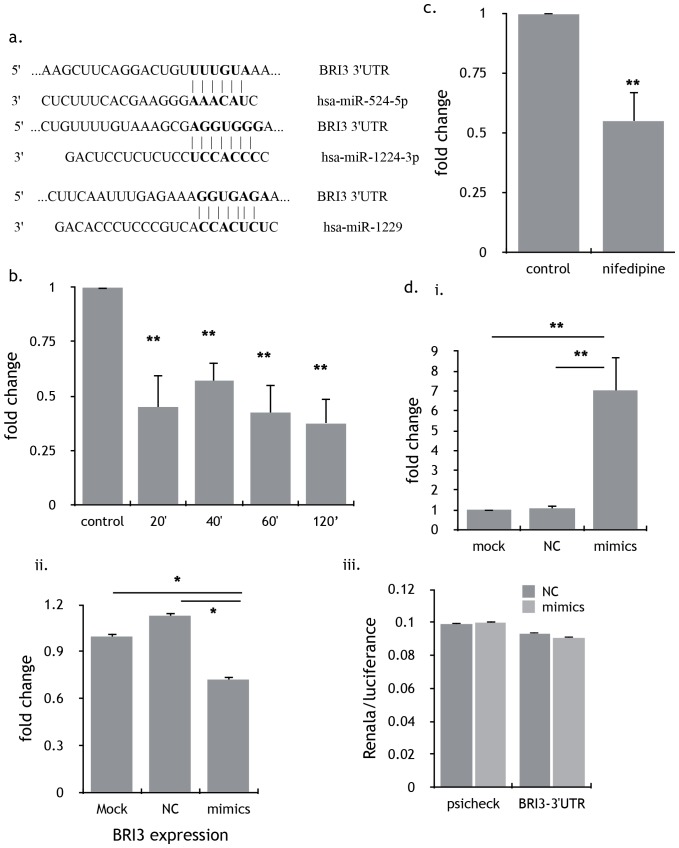
miRNA-524-5p was target of nifedipine and regulated the expression of BRI3.a) Predicted duplex formation between human BRI3 3′-UTR (top) and three miRNA (bottom) including has-miRNA-524-5p, hsa-miR-1224-3p, hsa-miR-1229 by using TargetScan software. b) The expression of miRNA-524-5p decreased in the MDA-MB-231 cells treated with nifedipine for different periods. Results were presented as the mean±SEM of three independent experiments. P<0.01, 1-way ANOVA. c) The expression of miRNA-524-5p decreased in the tumor tissues from nude mice fed with nifedipine compared to CMC-Na groups. Results were presented as the mean±SEM of three independent experiments. P<0.05, 1-way ANOVA. d) Overexpression of miRNA-524-5p could indirectly decrease the expression of BRI3 gene. i) MDA-MB-231 cells were transfected with miRNA-524-5p mimics and negative control (both 100 nM) for 24h. To test the expression of miRNA-524-5p by qPCR and the expression of miRNA-524-5p increased about 8 times. Results were presented as the mean±SEM of three independent experiments. P<0.01, 1-way ANOVA. ii) The expression of BRI3 gene decreased obviously compared with negative control when miRNA-524-5p overexpressed. Results were presented as the mean±SEM of three independent experiments. P<0.05, 1-way ANOVA. iii) Relative luciferase activity (Renilla luciferase/Firefly luciferase) levels were measured after 24h from co-transfection of MDA-MB-231 cells with indicated BRI3-3′UTR-psiCHECK2 plasmid with miRNA-524-5p mimics or NC. The relative luciferase activity has no change. Results were presented as the mean±SEM of three independent experiments. P>0.05,1-way ANOVA.